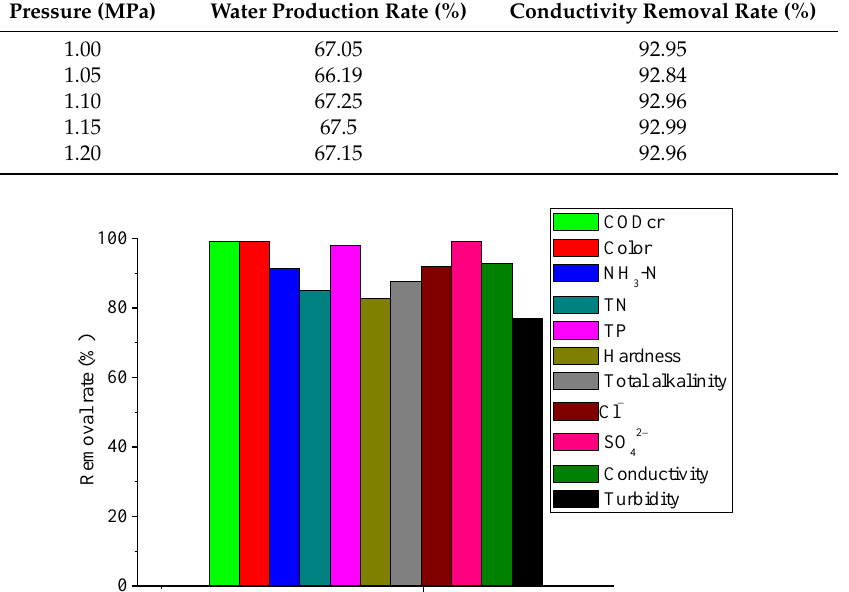
Figure 8. Removal rate of pollutants in the primary RO process . Table 3 . Pollutants of the effluent after the primary RO treatment .